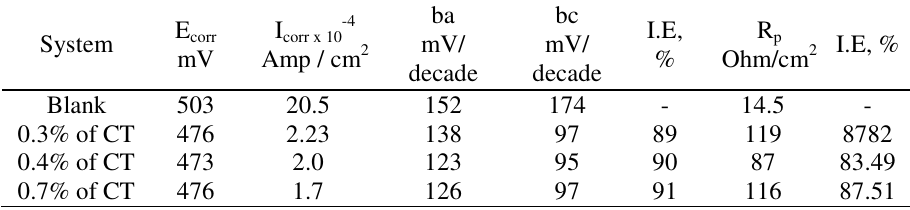
Table 2 . Polarization data and IE of CT in 1M